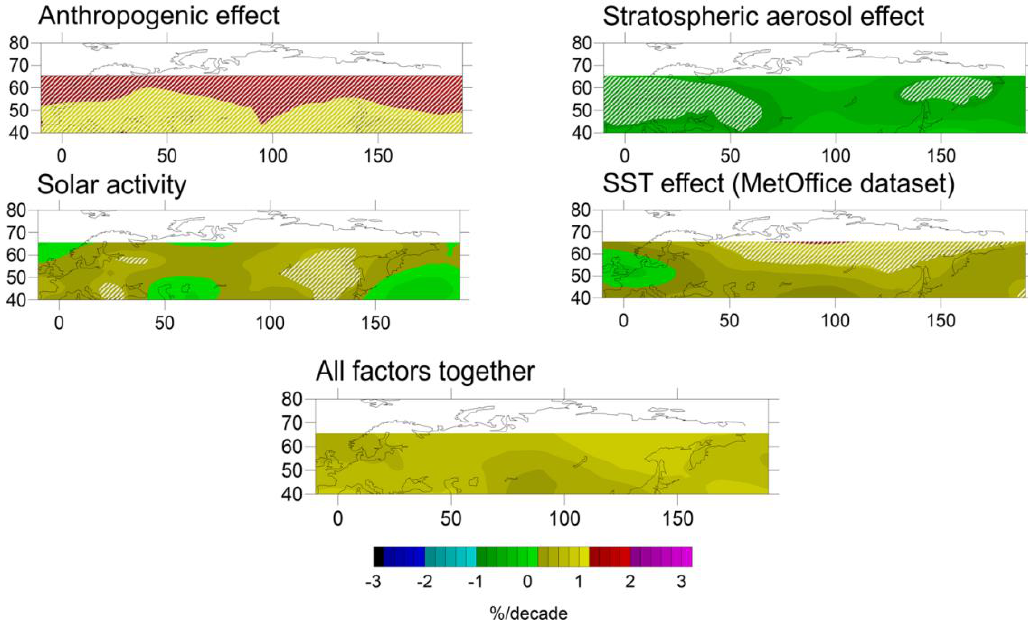
Figure 6. Decadal trends in annually averaged Eery anomalies (%/decade) due to changes in total ozone column according to the effects of anthropogenic (ODS) and different natural factors. INM-RSHU CCM simulations, 1979–2015. Statistically significant trends at 95% are shown by white hatching. X-axis—is longitude, Y-axis—is latitude.